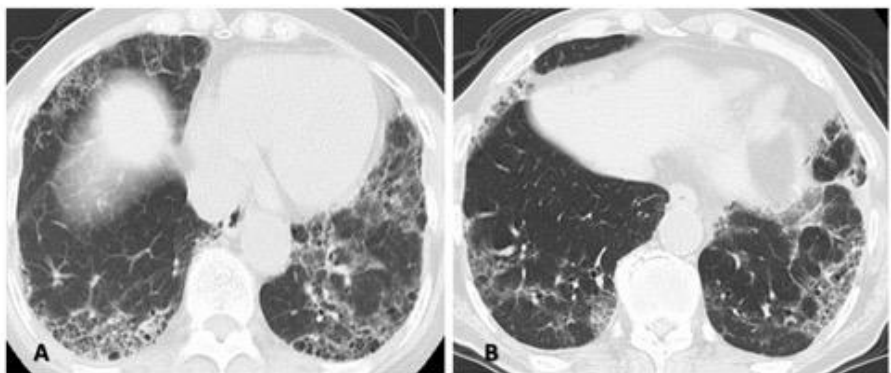
Figure 4. Two cases illustrating the difficulty of classifying a specific high-resolution computed tomography pattern as a mixed NSIP/UIP pattern. Both central or diffuse distribution of reticulation or ground-glass opacity as the component of NSIP and subpleural reticulations with or without honeycombing as the component of UIP in the lower lung are shown. ( A ) A 71-year-old woman and ( B ) a 72-year-old man. Abbreviations: NSIP = nonspecific interstitial pneumonia; UIP = usual interstitial pneumonia.